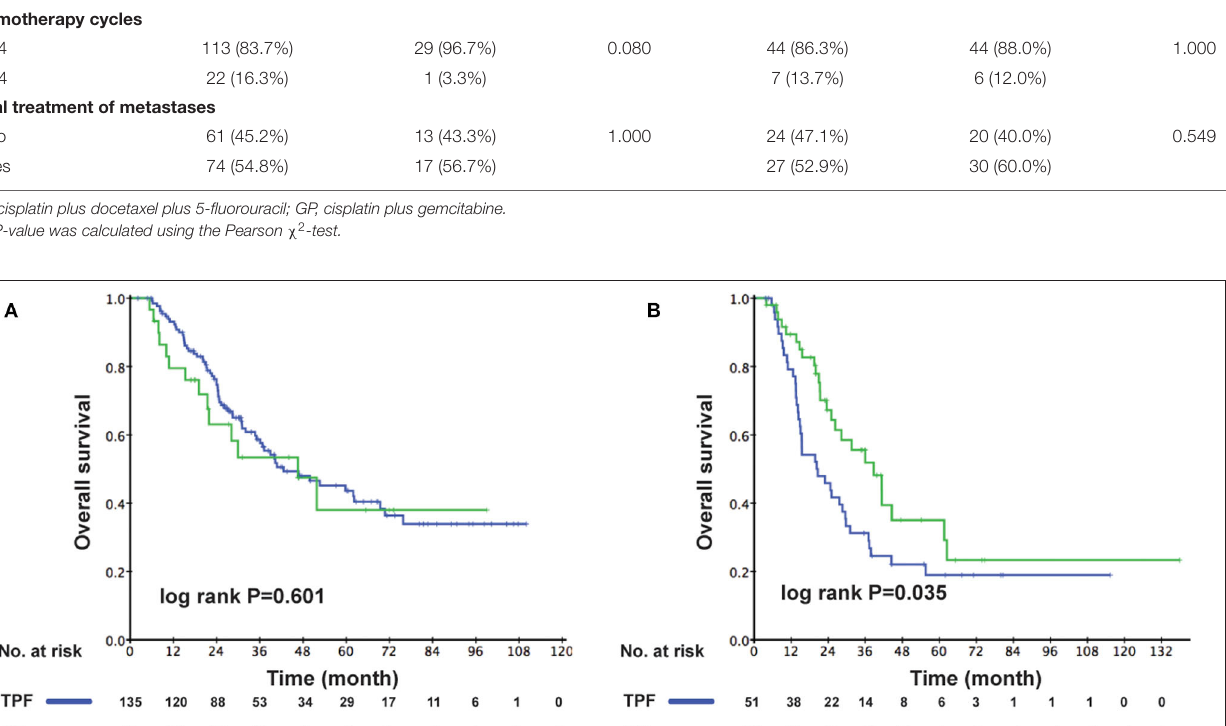
Additionally, our group verified that secondary metastases were associated with worse prognosis than primary